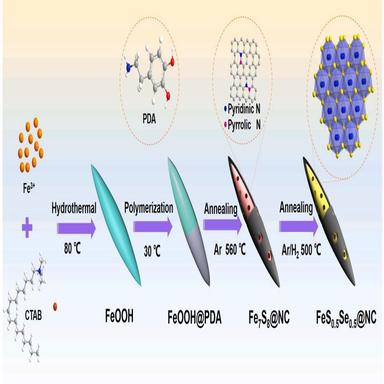
Synthesis process of FeS0.5Se0.5@NC.